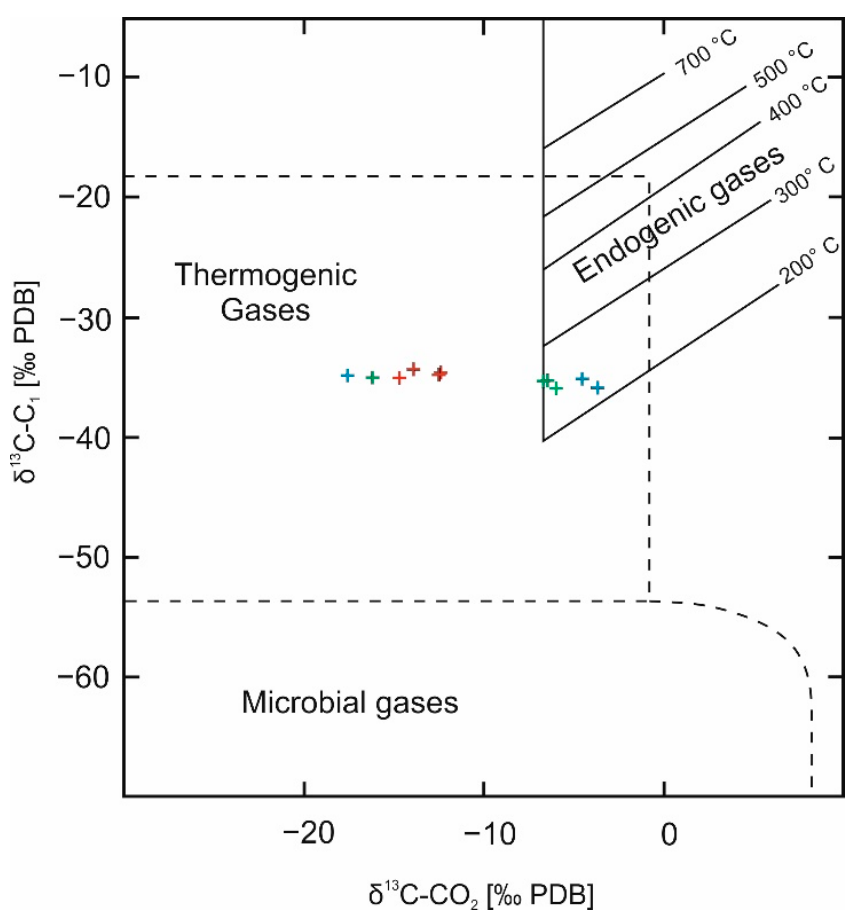
Figure 6. Carbon isotopic composition of methane versus carbon dioxide [22]. The location of points corresponding to the analysed samples on the graph of the δ 13 C-C δ 13 C-CO 1 and 2 relationships indicates mainly the thermogenic origin of the gas, although a shift of some points towards the area typical for endogenous gases is also noticeable (Figure 6). The shift of those results towards the area of endogenic gases can be attributed to the enrichment of carbon dioxide in the heavy 13 C isotope and it applies to some of the samples of gas dissolved in brine, drawn both, in 2018 and 2019. In the samples of gas dissolved in brine carbon isotopic composition of CO 2 could be shifted towards heavier values as a result of easier dissolving of isotopically lighter CO 2 in brine. Such dissolution results in enrichment of CO 2 with 13 C in natural gas. The enrichment of carbon dioxide in a heavier isotope may result from pressure changes in the reservoir caused by annual downtime and release of gas from the blind parts of the reservoir (ventilation/homogenisation). Such an enrichment in the heavier 13 C isotope can also result from the reduction of carbon dioxide. The isotope composition of carbon in methane, ethane, and propane appears to be unchanged and independent of the type of gas sample drawn and the time of sampling. The differences in the extreme values of carbon isotope composition in methane are about 1.5‰ (approximately 4%) and, in ethane and propane, ca. 0.4‰ (approximately 1.5%). However, some changes in the isotope composition of hydrogen in methane are notice- able. The isotope composition of hydrogen in the extracted gas samples is